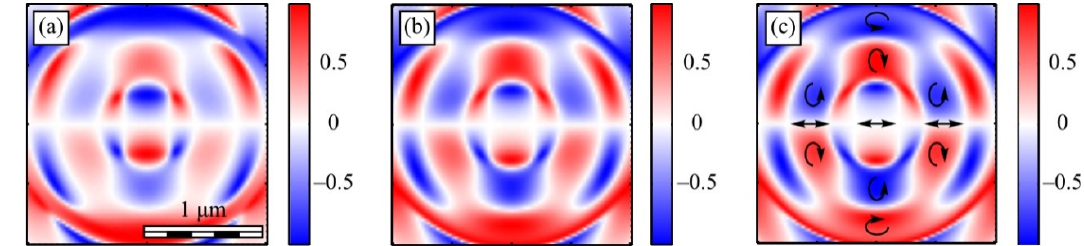
Figure 12. The third component of the normalized Stokes vector (16) S 3 of the focused vector field (1) with m = 3 and different parameters a : 1/2 ( a ), 1 ( b ) and 3/2 ( c ). Arrows indicate the circular, elliptical or linear polarization.